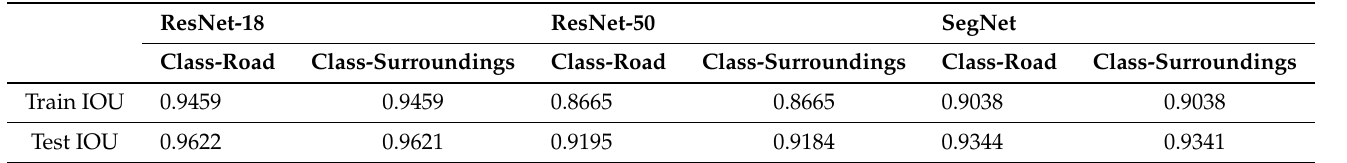
Table 9. Class-wise IOU score for the proposed model architectures.